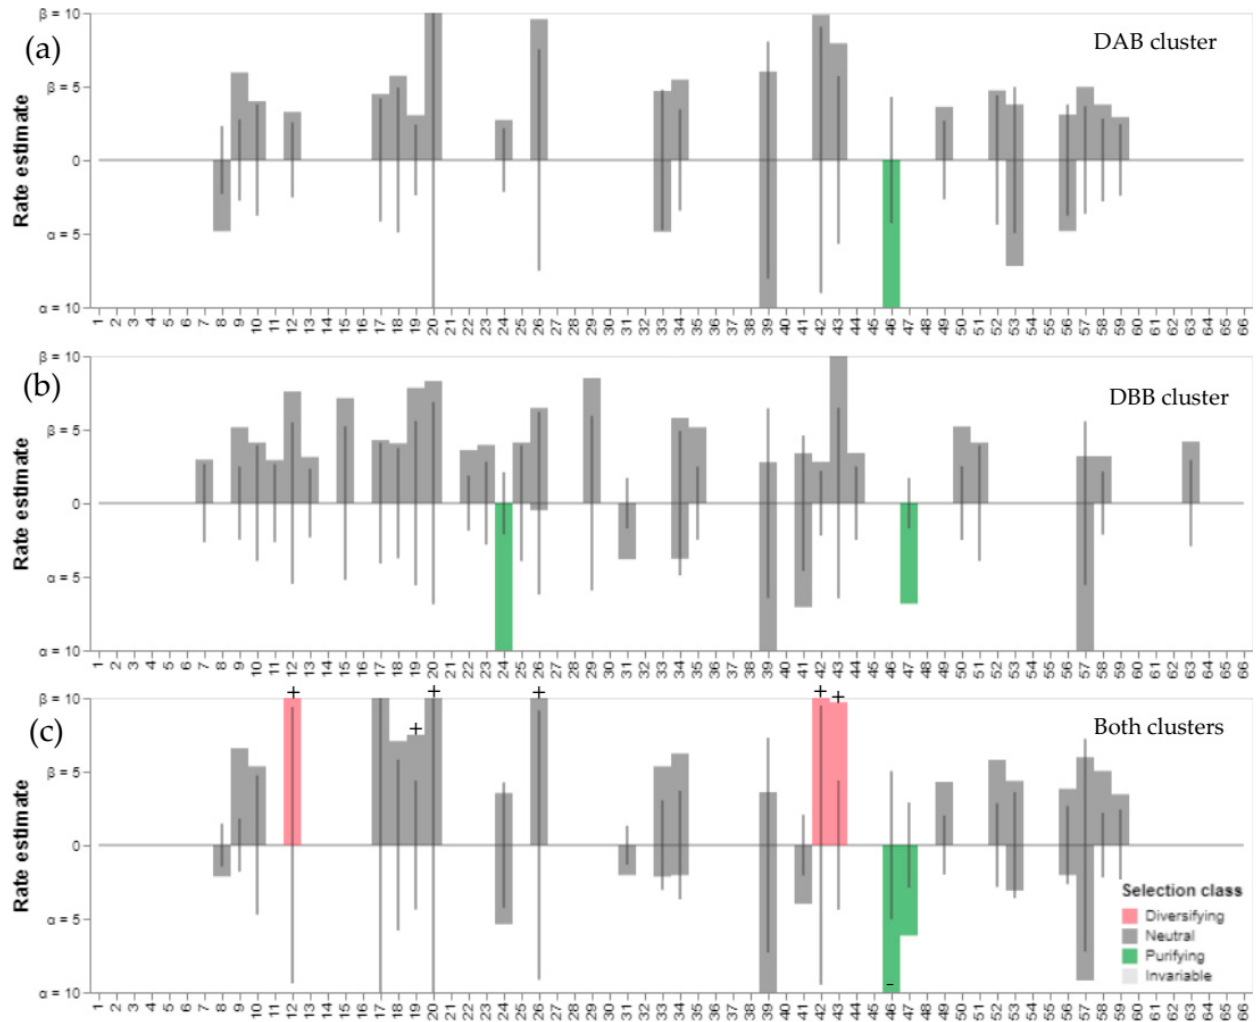
Figure 4. Synonymous ( α ) and non-synonymous ( β ) substitution rates assessed by the FEL approach for Heermann’s Gull MHCIIB alleles in two clusters (or putative loci): ( a ) DAB and ( b ) DBB. Estimates at each site are shown as bars and lines, indicating the estimates under the null model ( α = β ). The DAB cluster showed more invariant sites than the DBB cluster and only one (DAB) or two (DBB) sites displayed significant purifying selection (green bars) at each cluster. ( c ) For both clusters the maximal likelihood FEL approach revealed diversifying selection at three sites (pink bars), purifying selection at two sites (green bars), and non-significant neutral selection (gray bars) at the other twenty-one variable sites. In comparison, the Bayesian FUBAR approach indicated consistent signatures of positive selection (+) at three out of five sites and one out of two sites under negative selection ( − ) inferred by FEL.